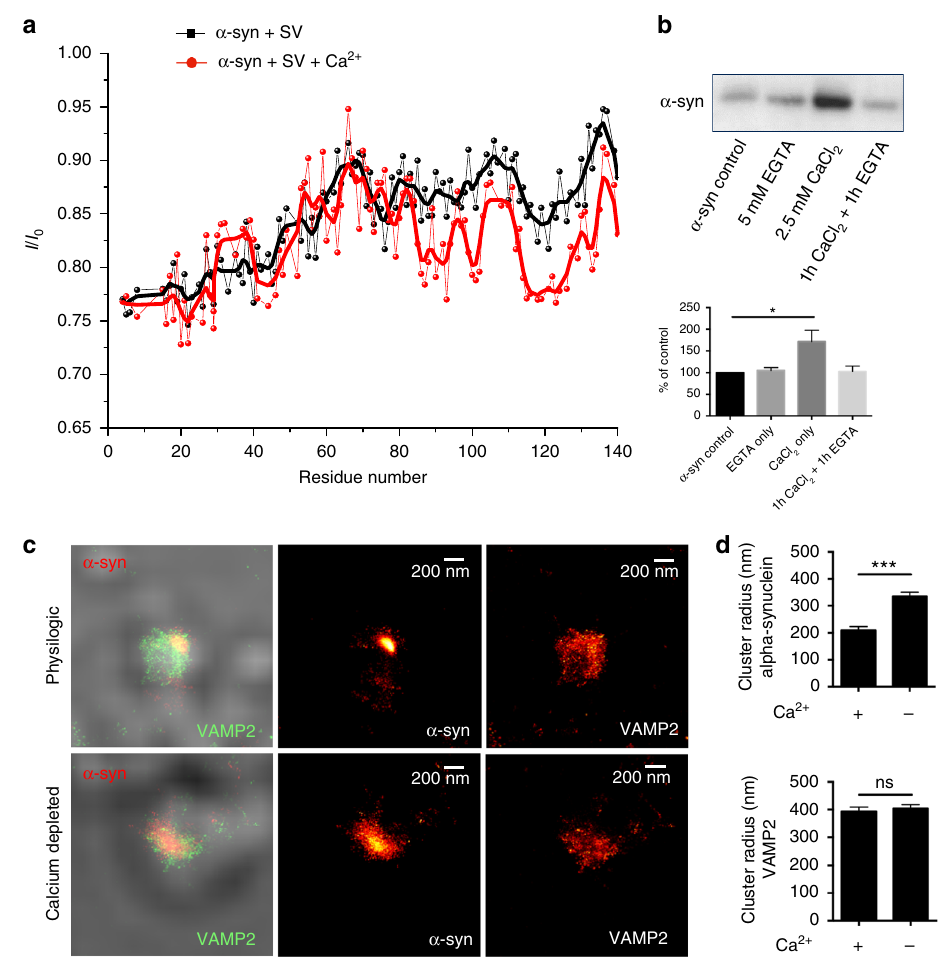
Fig. 2 The C terminus of alpha-synuclein binds to synaptic vesicles upon calcium binding. a CEST-NMR experiments were performed on alpha-synuclein and synaptic vesicles in the absence (black) or presence of calcium (red, 6 mM). In the absence of calcium, the N terminus shows the strongest interaction with synaptic vesicles. Upon addition of calcium, the interaction of the C terminus and also of some residues of the NAC-region increases, which is seen as a reduction of the signal. Experiments were repeated twice. b Lipid pull-down experiment showing the transient nature of alpha-synuclein lipid binding. Western blot of the amount of alpha-synuclein pulled down by the lipids showing that calcium-induced lipid binding of alpha-synuclein is reversible upon addition of the calcium chelator EGTA. * p = 0.0263, calculated using one-way ANOVA with Tukey ’ s post-hoc correction, graphs indicate mean ± s.e.m. N = 6 for control and CaCl n = 4 for EGTA and CaCl + EGTA, data from three biological repeats, d.f. 16. c d STORM super-resolution imaging of alpha- 2 , 2 synuclein and VAMP2 on isolated synaptosomes displaying alpha-synuclein clustering under normal physiological conditions with 2.5 mM calcium in the extracellular buffer (upper panel). Upon calcium depletion in the extracellular buffer, using 1 mM EGTA, alpha-synuclein localization was dispersed (lower panel). d Cluster analysis of alpha-synuclein and VAMP2 immunostaining showing increased cluster size of alpha-synuclein upon calcium depletion, whereas VAMP2 cluster size is the same either in the presence of calcium or upon calcium depletion in the extracellular buffer. **** p < 0.0001, ns p = 0.6363 calculated using two-tailed t -test, graphs indicate mean ± s.e.m. N = 22 for + Ca 2 + and n = 30 for − Ca 2 + , where n indicates single synaptosomes, data form three biological repeats, d.f.